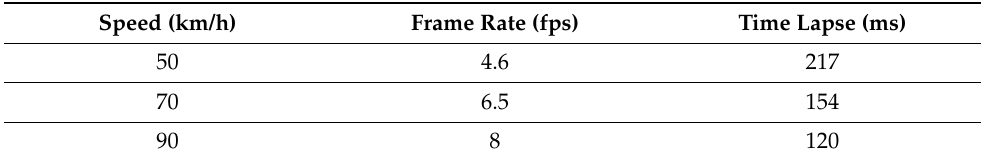
Table 2. Tradeoff between vehicle speed and camera frame rate to achieve a 3.5 m overlap between consecutively captured